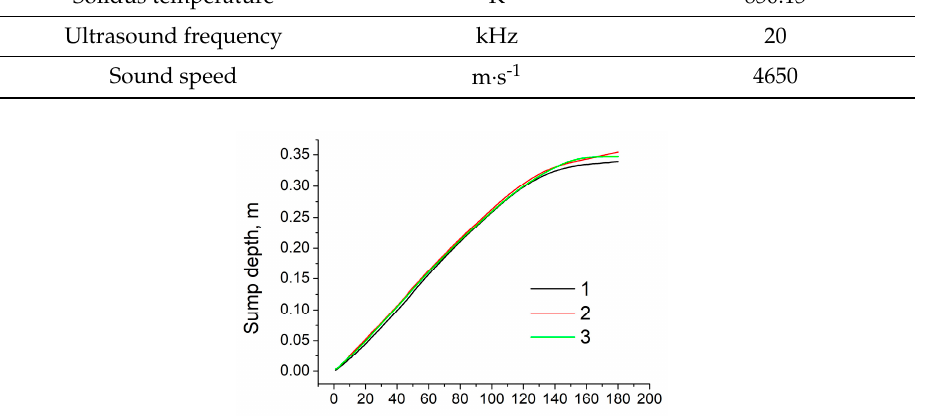
Figure 6. Time variation of sump depth. 1: conventional casting; 2: UST HT castingmaterials-625822 3: UST FRHT casting.